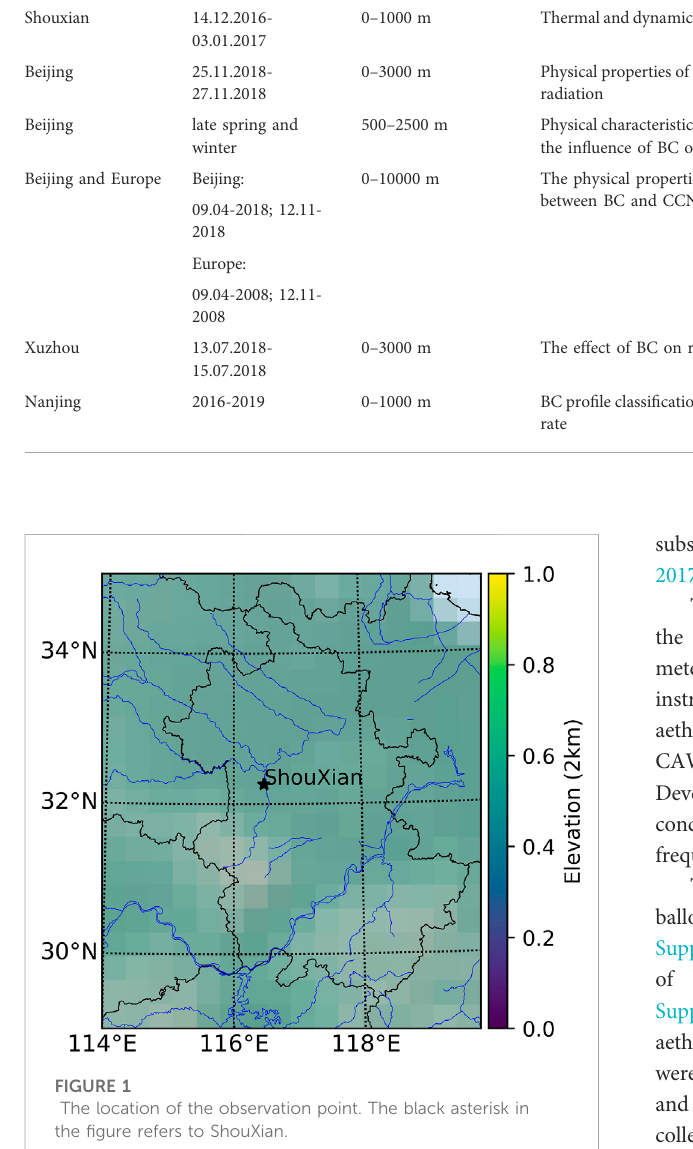
TABLE 1 Comparison of research contents of BC vertical sounding in different regions of China. Observation area